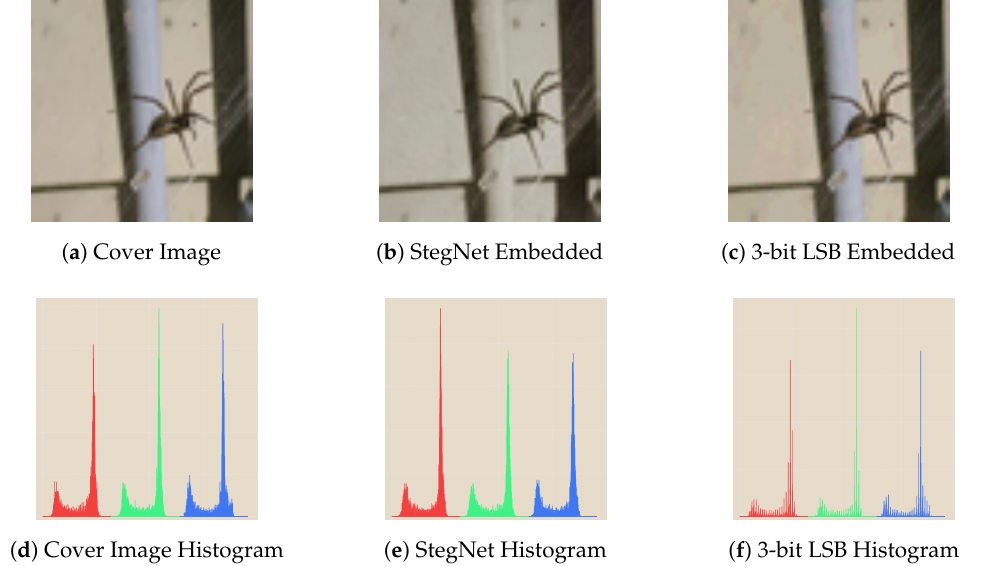
Figure 14. Histogram Comparison between StegNet and Plain LSB.